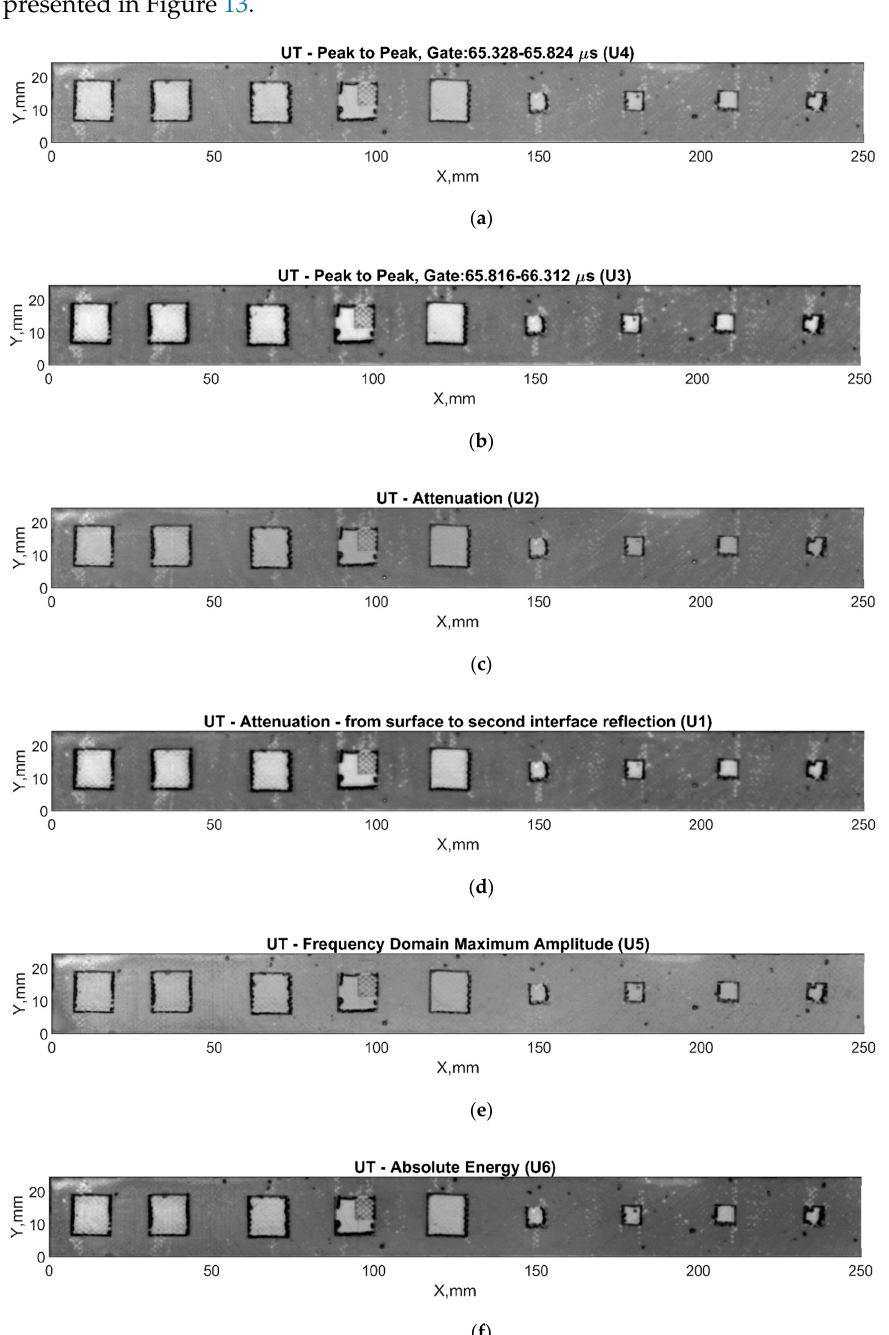
Figure 11. C-scans of different ultrasonic features: ( a ) peak-to-peak amplitude in the region from 2 to 11; ( b ) peak-to-peak amplitude in the region from 11 to 17; ( c ) attenuation in between gates 2 and 11; ( d ) attenuation in between gates 11 and 17; ( e ) frequency domain max amplitude; ( f ) absolute